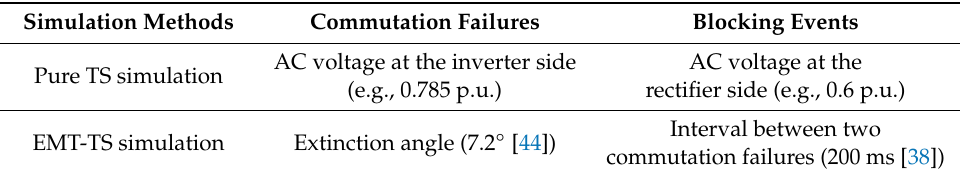
Table 1. Typical criteria of commutation failures and blocking events in two simulation methods.